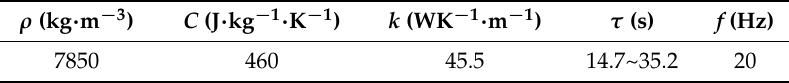
Table 3. Thermo-physical and boundary parameters of the welded